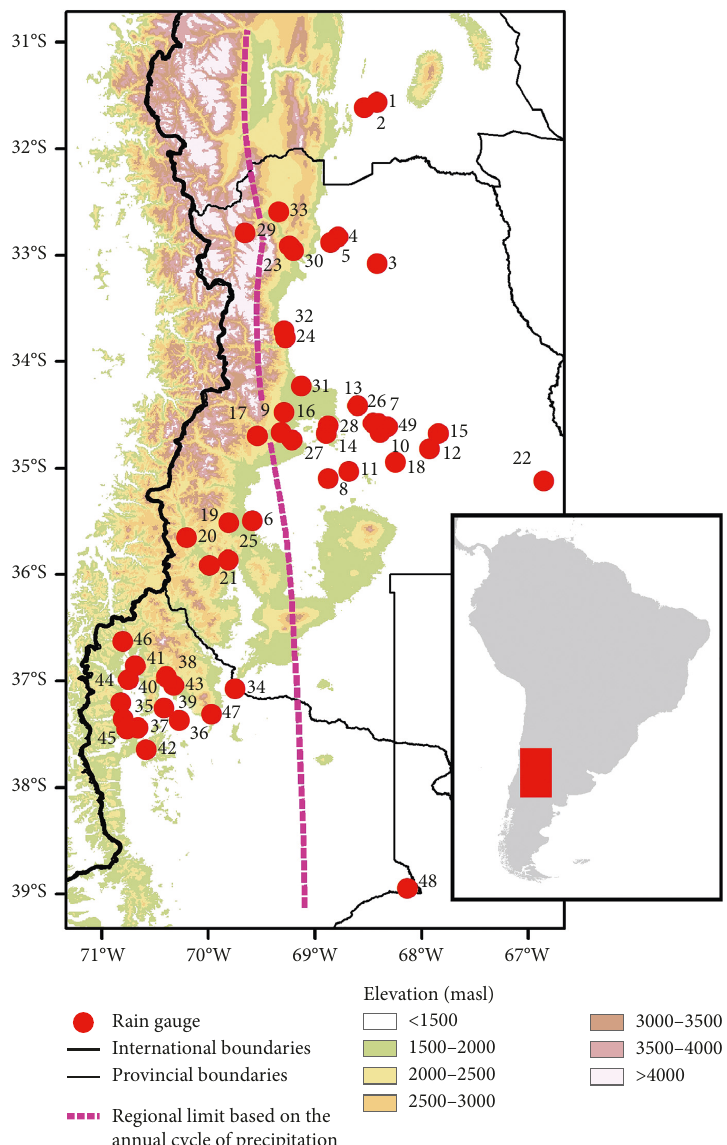
Figure 1: Map of the Central-Western Argentina, with the location and ID (see Table 1 for details) of the rain gauges used for the validation of CHIRPS. The dashed line represents the division between the rainy season characteristics: the stations located west of the line are dominated by winter precipitation, while the stations located east of the line are dominated by summer